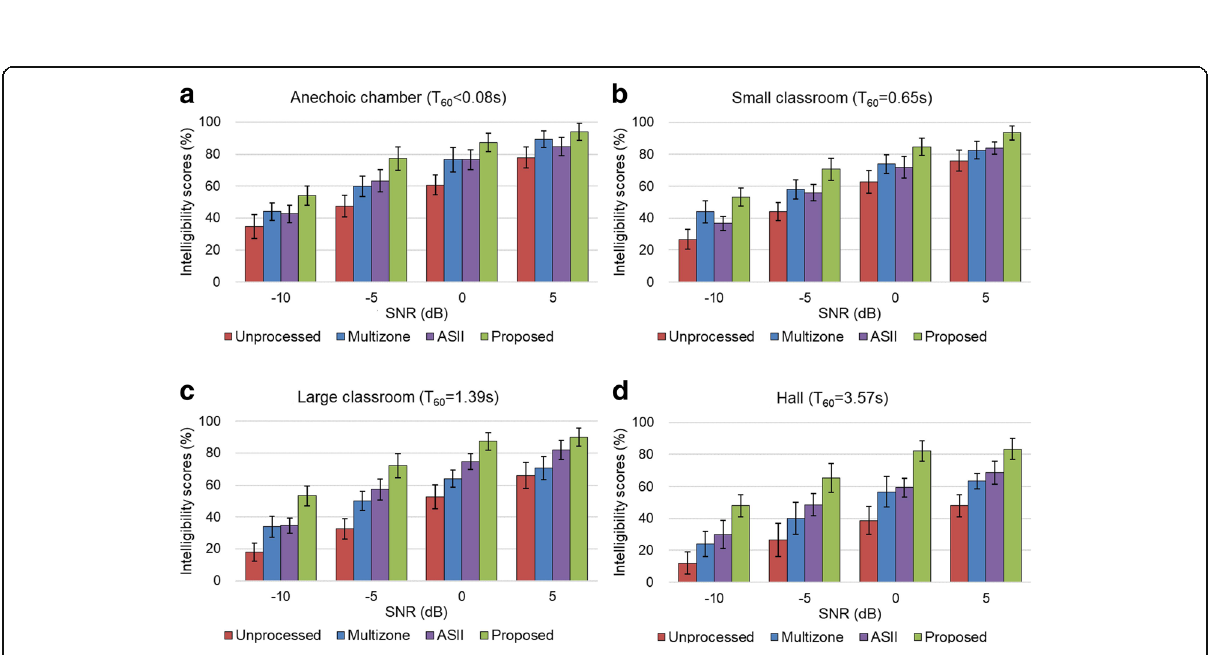
Fig. 7 Results of listening test under different RT and SNRconditions. a anechoic chamber ( T 60 = 0.08s), b small classroom ( T 60 = 0.65s), c large classroom ( T 60 = 1.39s), d hall T 60 =